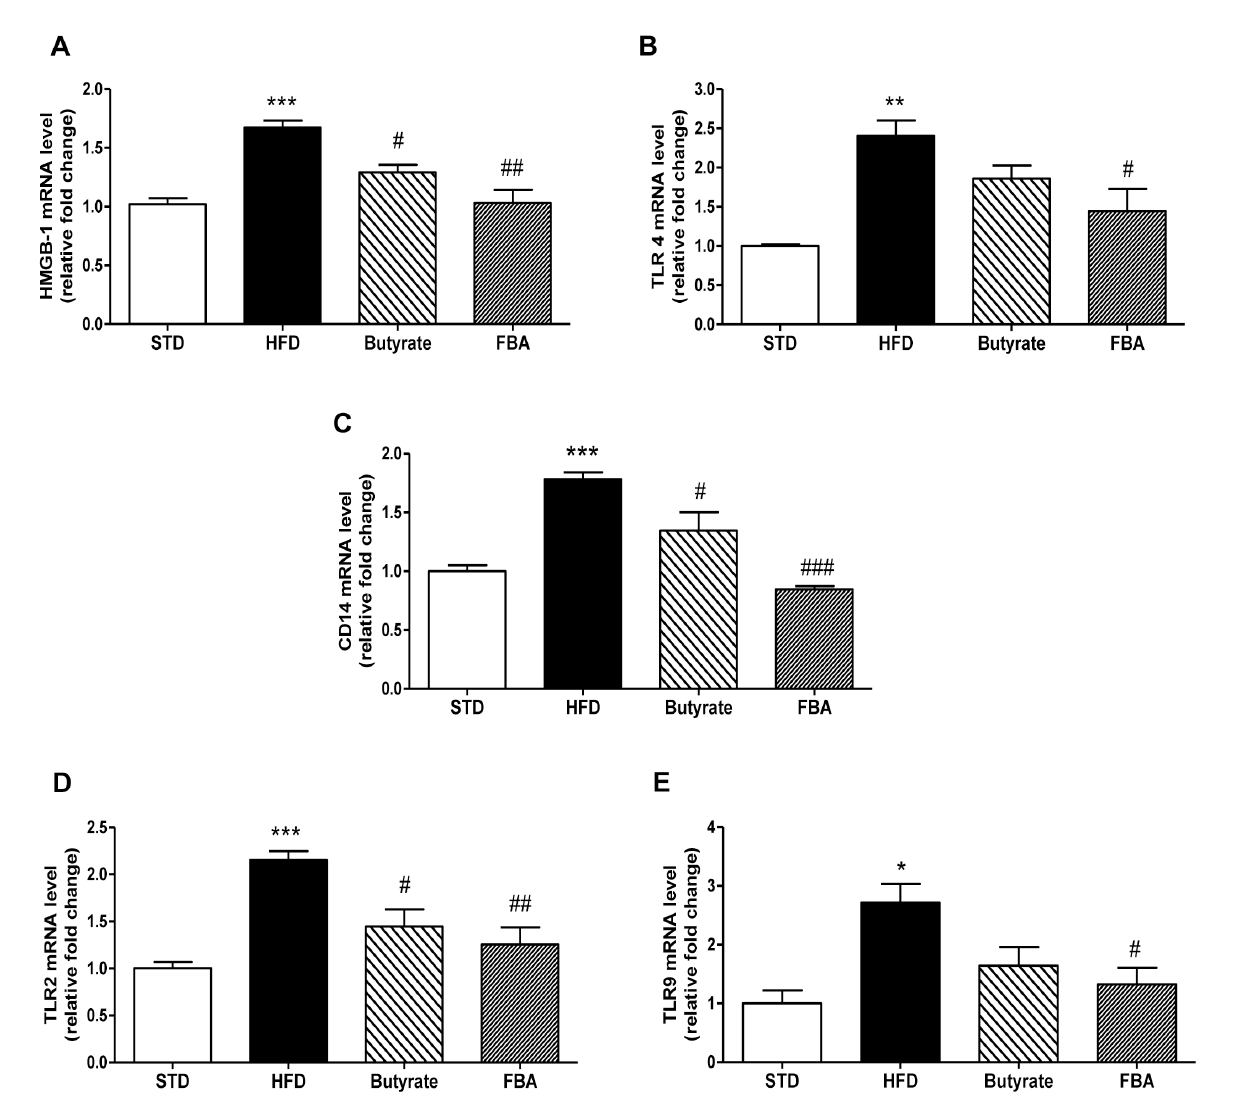
Figure 3. Effect of butyrate and FBA on hepatic Toll-like receptors pattern. Panels A and B are the results of real-time PCR for HMGB-1 and TLR4, respectively, in liver extracts from 6 rats on STD, HFD, HFD+butyrate, and HFD+FBA. Panel C shows mRNA expression of coreceptor CD14. TLR2 (D) and TLR9 (E) mRNA levels are shown and expressed as relative fold change to STD. *P<0.05, **P<0.01 and ***P<0.001 vs STD; # P<0.05, # # P<0.01, # # # P<0.001 vs HFD.